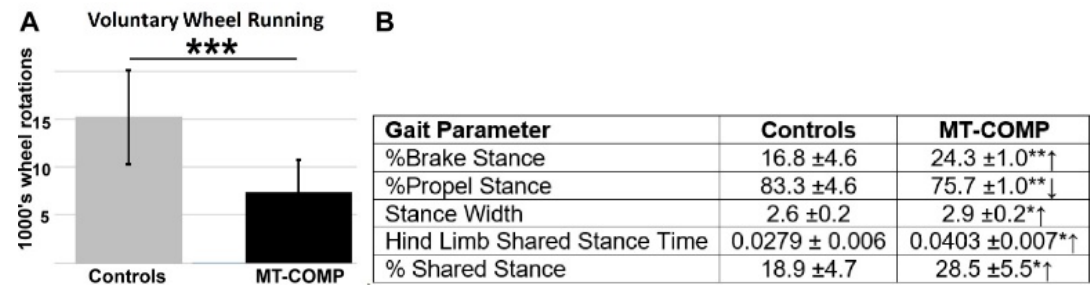
Figure 5. Voluntary running and gait indices. All mice were administered DOX from birth to collection. Voluntary running from 20–24 weeks ( A ) and gait indices ( B ) were measured at 16 weeks. MT-COMP mice ran approximately 50% less than the controls (N = 6/group). Select gait parameters associated with pain are shown and were significantly different ( ↑ , ↓ ) in MT-COMP mice compared to the controls (N = 6/group). MT-COMP mice had increased ( ↑ ) % brake stance, stance width, hind limb shared stance time, and % shared stance while % propel stance was decreased ( ↓ ). % Brake Stance = the percentage of the stance spent in braking; % Propel Stance = the percentage of the stance spent in propulsion; Stance Width = the perpendicular distance between the centroids of either set of axial paws during peak stance; Hind Limb Shared Stance Time = length of time both hind paws contact belt; % Shared Stance = the percentage of the stance spent with both hind paws in contact with the belt. * p < 0.05; ** p < 0.005; *** p < 0.0005.